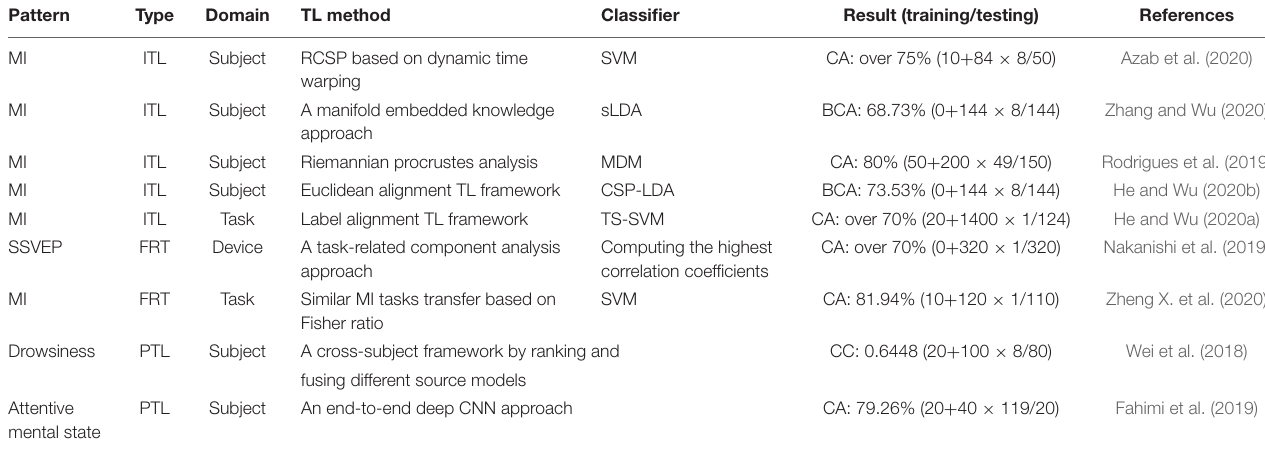
TABLE 2 | Summary of representative TL